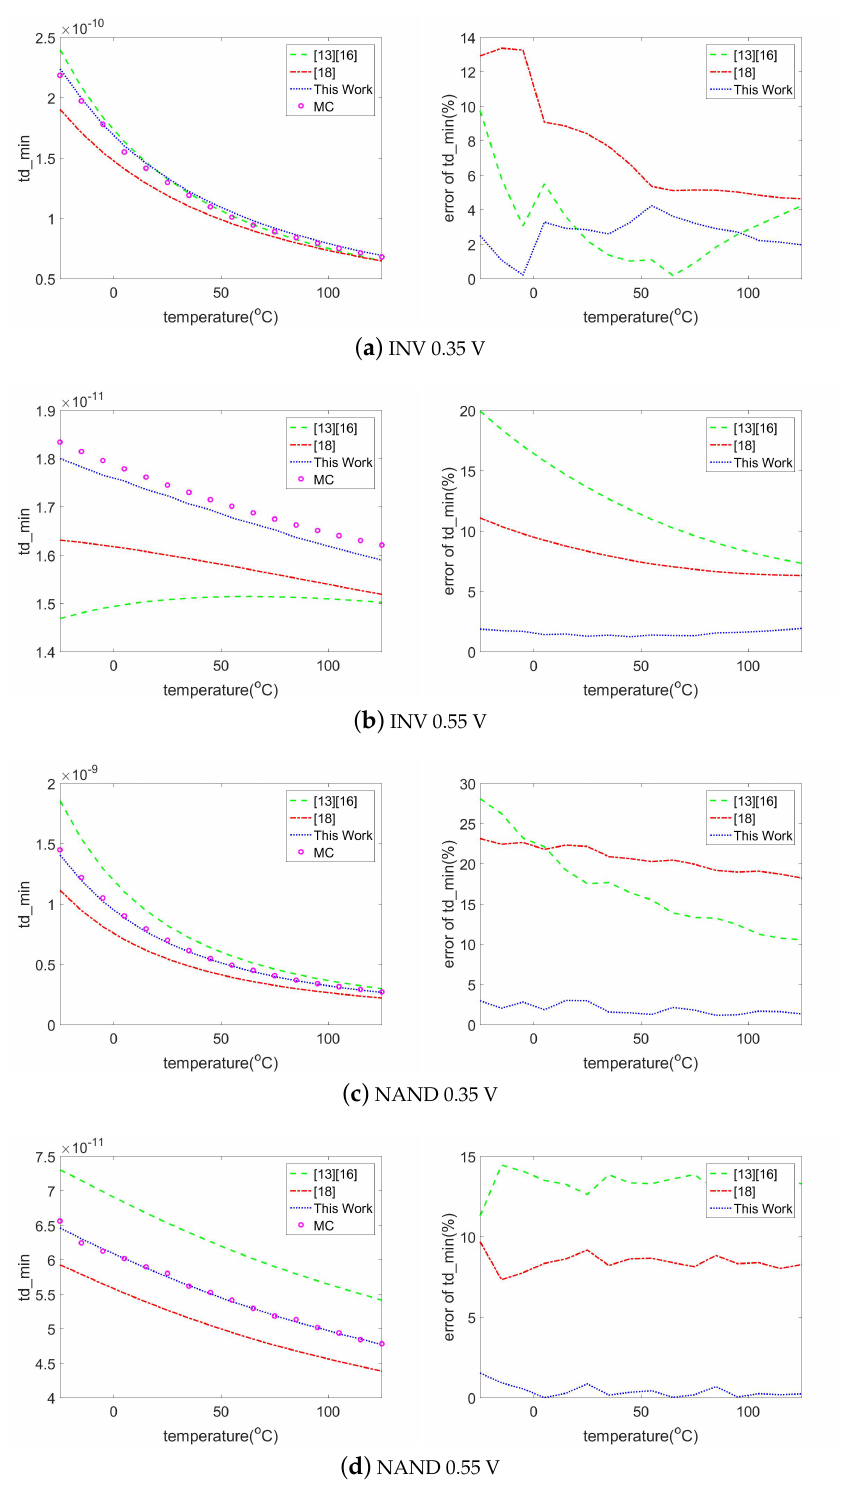
Figure 6. Comparison of minimum delay with different temperature under different gates and